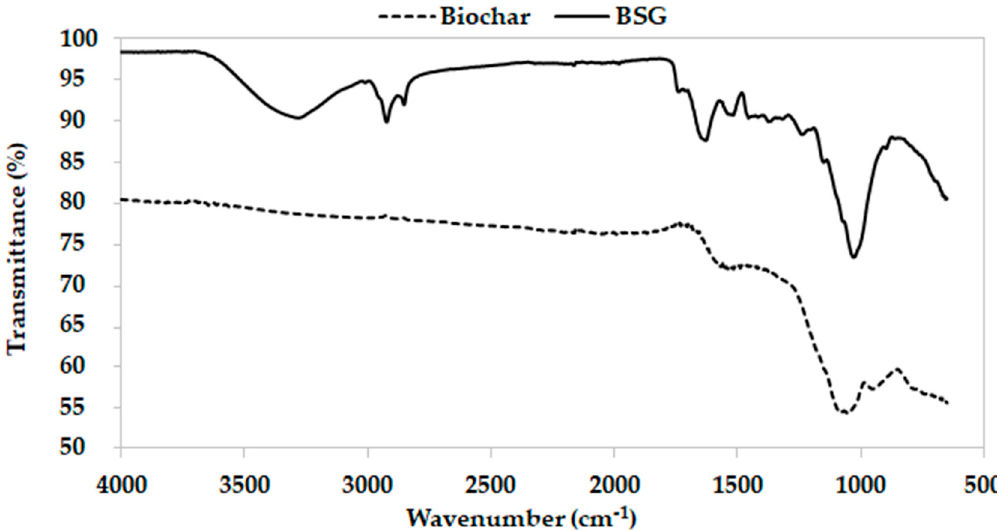
Figure 1. FT-IR spectra of brewers’ spent grain (BSG) and biochar.